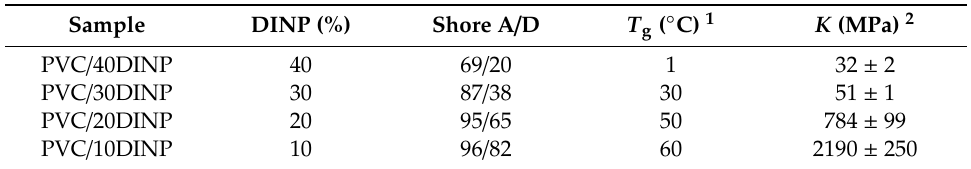
Table 1. PVC / DINP samples prepared by